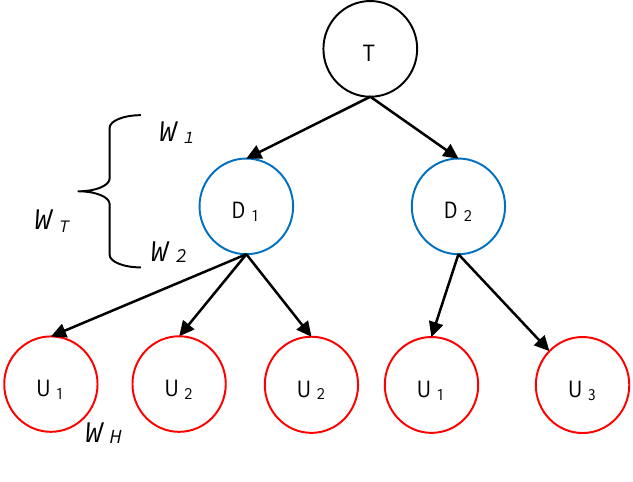
Figure 9. A weighted tree for route